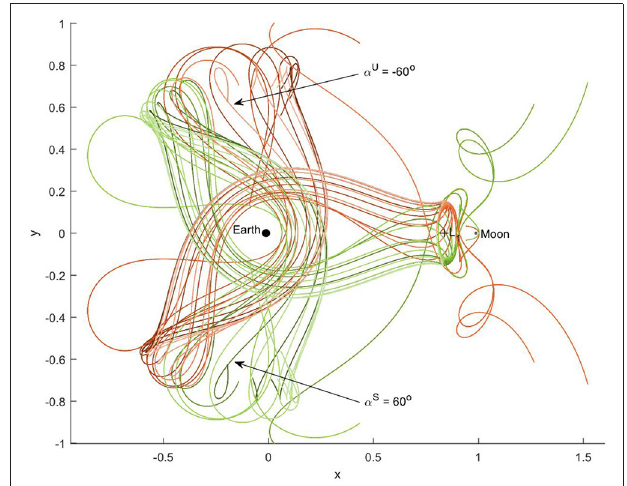
FIGURE 10 | Effect of non-zero pitch angle on the unstable (red) and stable (green) manifold trajectories of orbit 1 for i U M = i S M = 1, i.e., at t U M ,0 = t S M ,0 = 0, and for pitch angles between − 90 ◦ (dark color) and 90 ◦ (light color) with a step size of 10 ◦